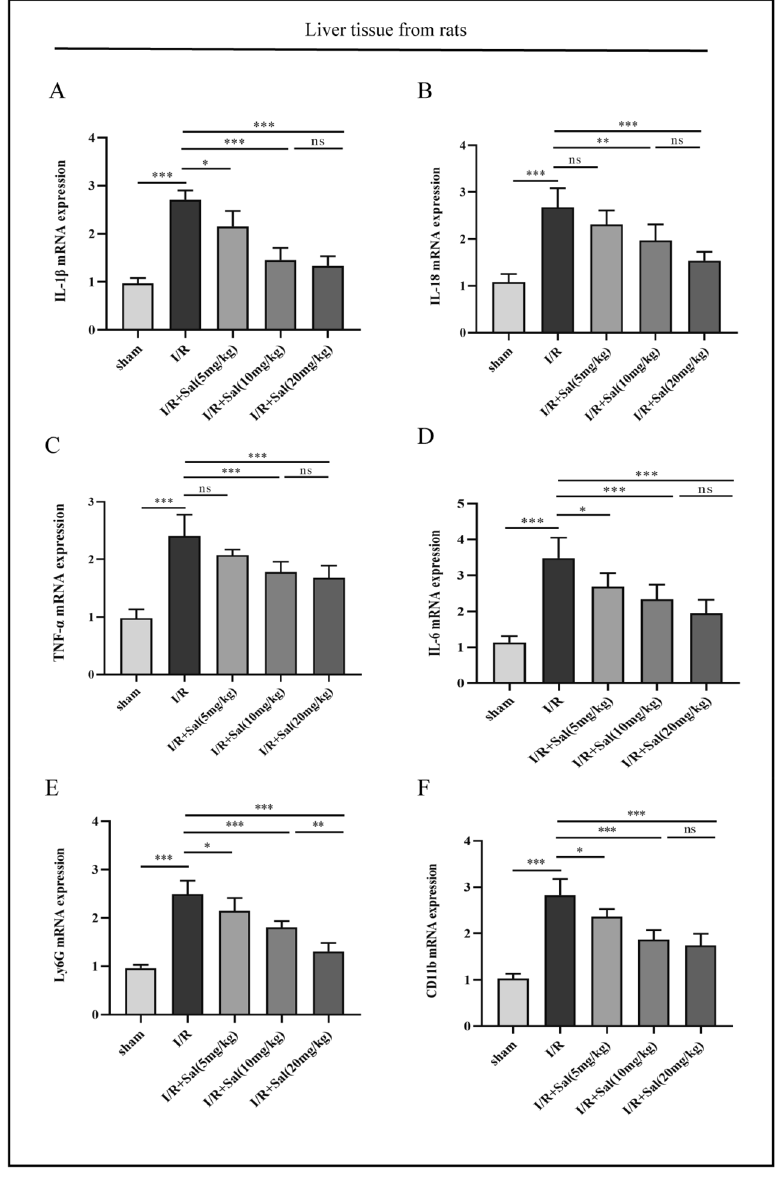
Figure 4. Salidroside suppresses transcription of pro-inflammatory cytokinesis. ( A ) IL-1β mRNA expression. ( B ) IL-18 mRNA expression. ( C ) TNF-α mRNA expression. ( D ) IL-6 mRNA expression. ( E ) Ly6G mRNA expression. ( F ) CD11b mRNA expression. The statistical differences among groups were assessed by one-way ANOVA. ns P > 0.05, * P < 0.05, ** P < 0.01, *** P <